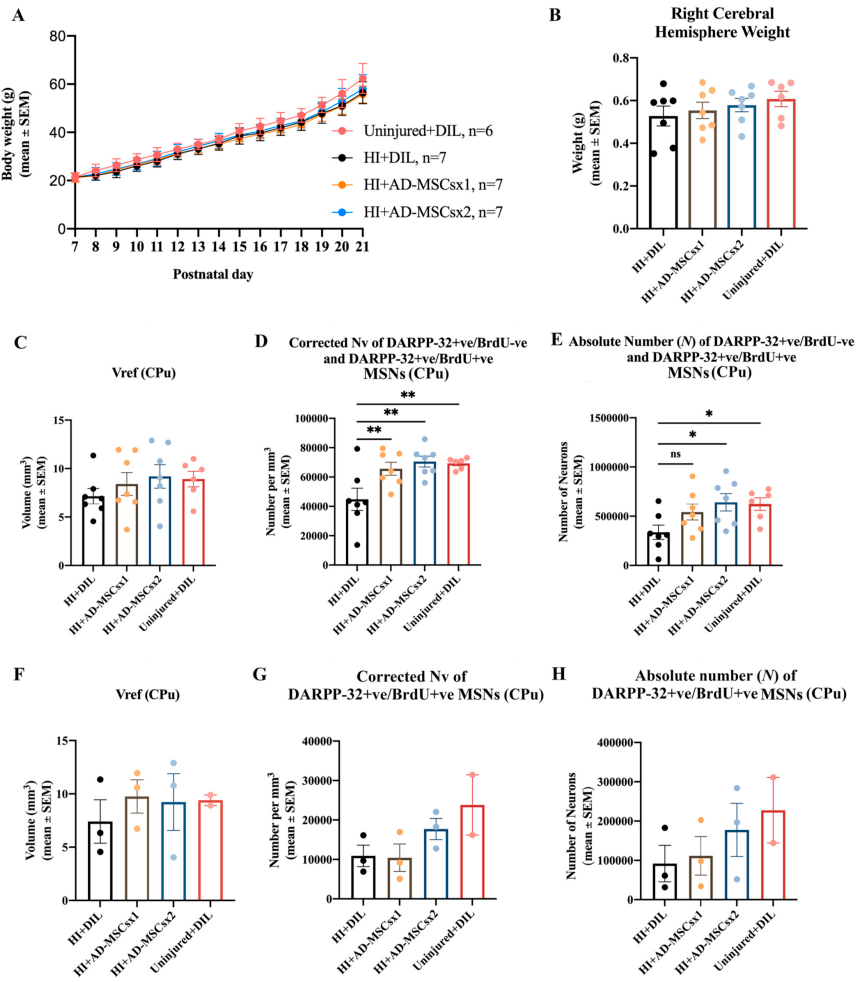
Figure 7. Results from the experiment on medium-spiny neurons (MSNs) in the caudate-putamen (CPu). Pups were exposed to one of the following conditions: hypoxia-ischemia (HI) and diluent (HI + DIL), single treatment with adipose-derived-mesenchymal stem cells (HI + AD-MSCs × 1), double treatment with AD-MSCs (HI + AD-MSCs × 2) or no HI and diluent (i.e., an uninjured control condition). ( A , B ) Effect of delayed treatment with either AD-MSCs, or diluent, on postnatal day (PN) 14 and PN16, after perinatal hypoxia-ischemia (HI) at PN7, on ( A ) the average body weight from PN7 to PN21, ( B ) the average right cerebral hemisphere brain weight at PN21, and ( C – E ) the stereological parameters relevant to the measurement of all MSNs within the CPu, including ( C ) the total reference volume (Vref) of the CPu, ( D ) the corrected density (Nv) of dopamine and cyclic AMP-regulated phosphoprotein (DARPP-32)-positive/bromodeoxyuridine (BrdU)-negative and DARPP-32-positive/BrdU-positive MSNs in the CPu, and ( E ) the absolute number ( N ) of DARPP-32-positive/BrdU-negative and DARPP-32-positive/BrdU-positive for each group. All data in C-E are from the right cerebral hemisphere at PN21. ( A – E ) n = 6/7 per group. In a subset of these animals ( F – H , n = 2/3 per group), the effect on progenitor DARPP-32-positive/BrdU-positive MSNs was also investigated. The stereological results relevant to this measurement of MSNs are indicated for ( F ) the total reference volume (Vref) for the CPu, ( G ) corrected density (Nv) of DARPP-32-positive/BrdU-positive MSNs in the CPu and ( H ) the absolute number (N) of DARPP-32-positive/BrdU-positive MSNs for each group. Note that three BrdU injections were administered daily, starting at 7 days after the induction of HI, to permit tracking of the differentiation of neuroblasts. The body weight data were statistically analyzed using used repeated measures ANOVA. The brain weight and stereological data were statistically analyzed used one-way ANOVA and Holm–Š í d á k’s post-hoc test corrected for multiple comparisons. * p < 0.05, ** p < 0.01. ns, not statistically significant. See also the text in the Results for more details on the statistical